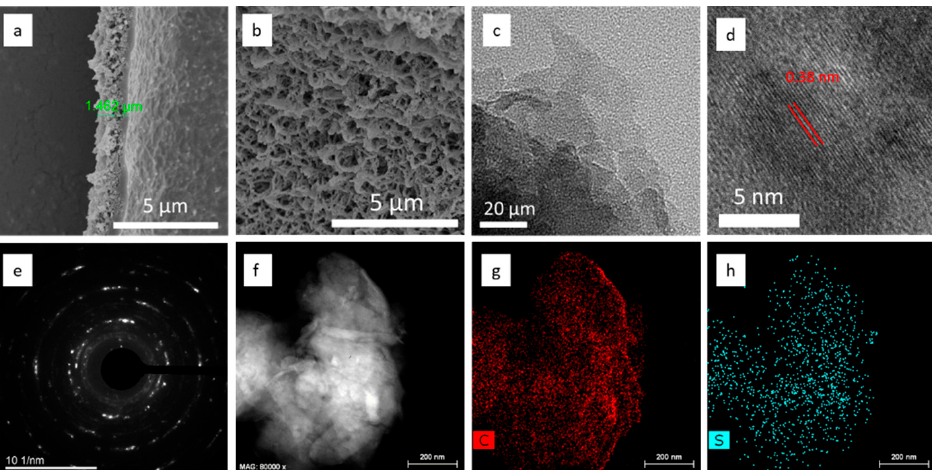
Figure 3. The morphology of S-GDY film: ( a ) the cross-section SEM image of the S-GDY film, ( b ) the top-view SEM image of the S-GDY film, ( c ) TEM image of the S-GDY, ( d ) HRTEM image of the S-GDY, ( e ) SAED pattern of the S-GDY, and ( f ) scanning transmission electron microscopy image and elemental mapping of ( g ) C-K and ( h ) S-K.